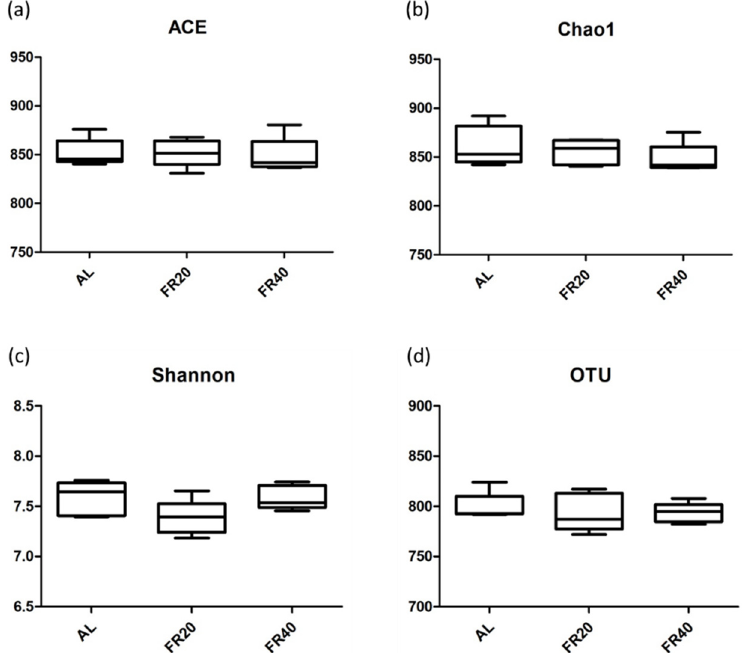
Figure 3. Differences in bacterial community diversity and richness in the cecum of laying hens among AL, FR20, and FR40 group. The community richness estimates of ( a ) ACE and ( b ) Chao1, the diversity indices of ( c ) Shannon, and ( d ) the OTU numbers are shown. AL: ad libitum with basal diet; FR20: basal diet with 20% feed restriction; FR40: basal diet with 40% feed restriction.